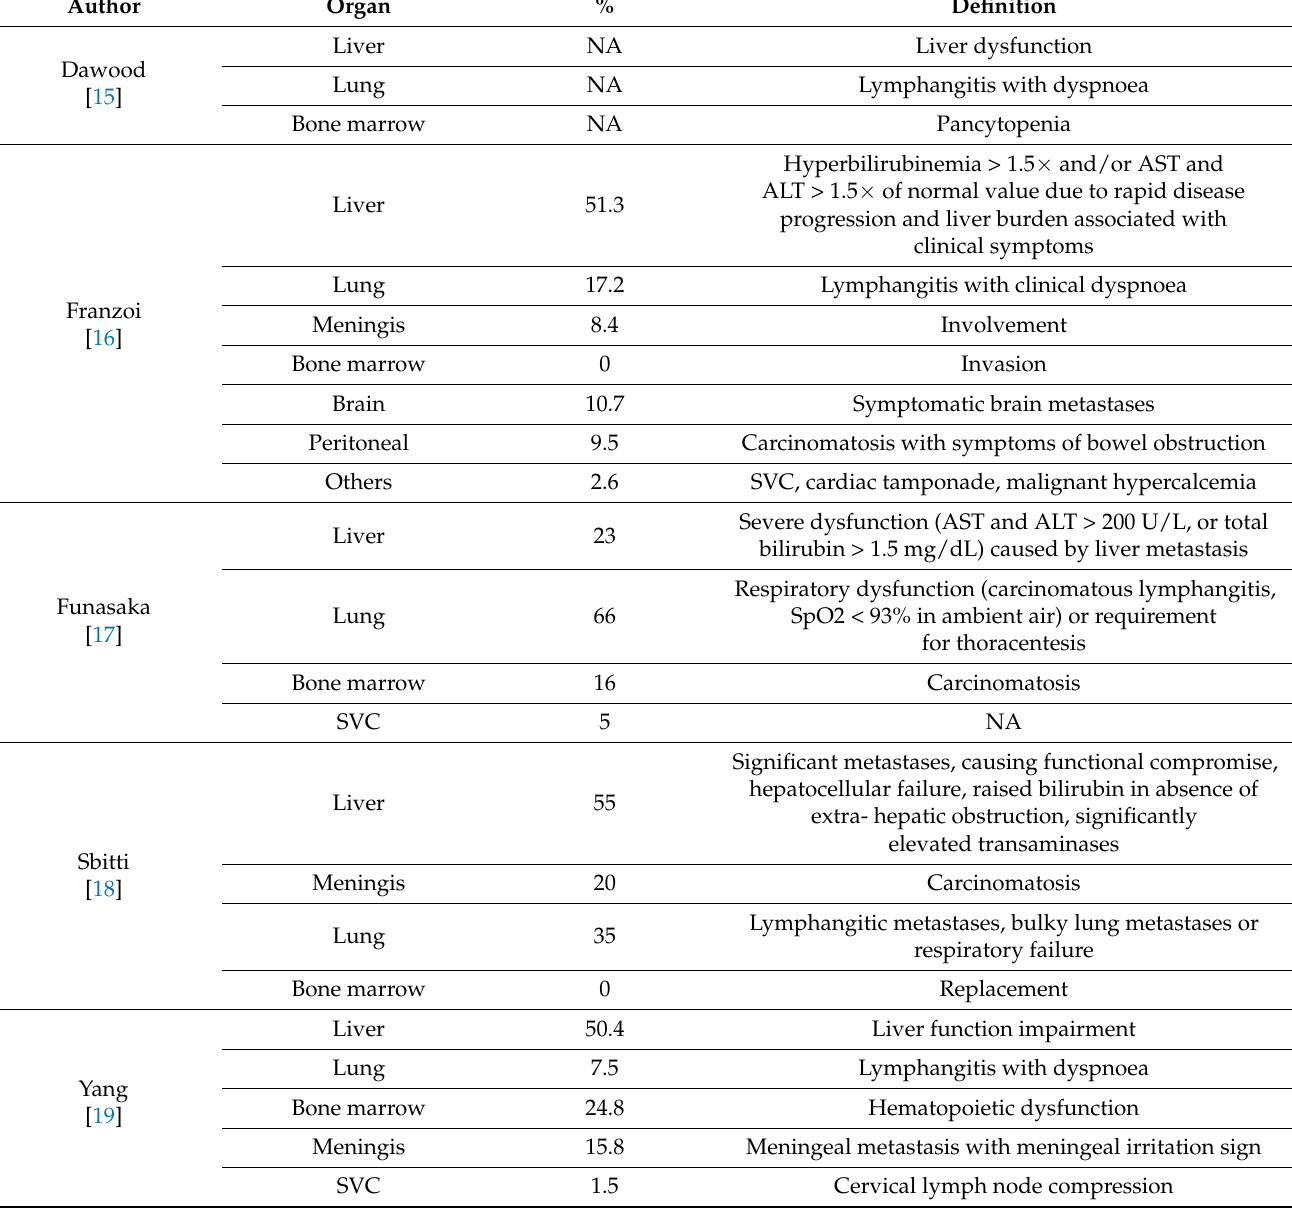
Table 2. Characteristics of the BC visceral crisis in the series available in the